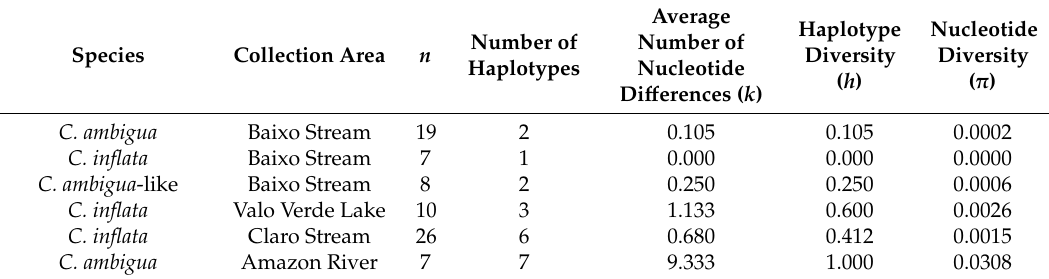
Table 7. Variation at the mitochondrial 16S region for Castalia species among three sites in the upper Paraguay River basin (original data) and the upper Amazon River basin of Brazil